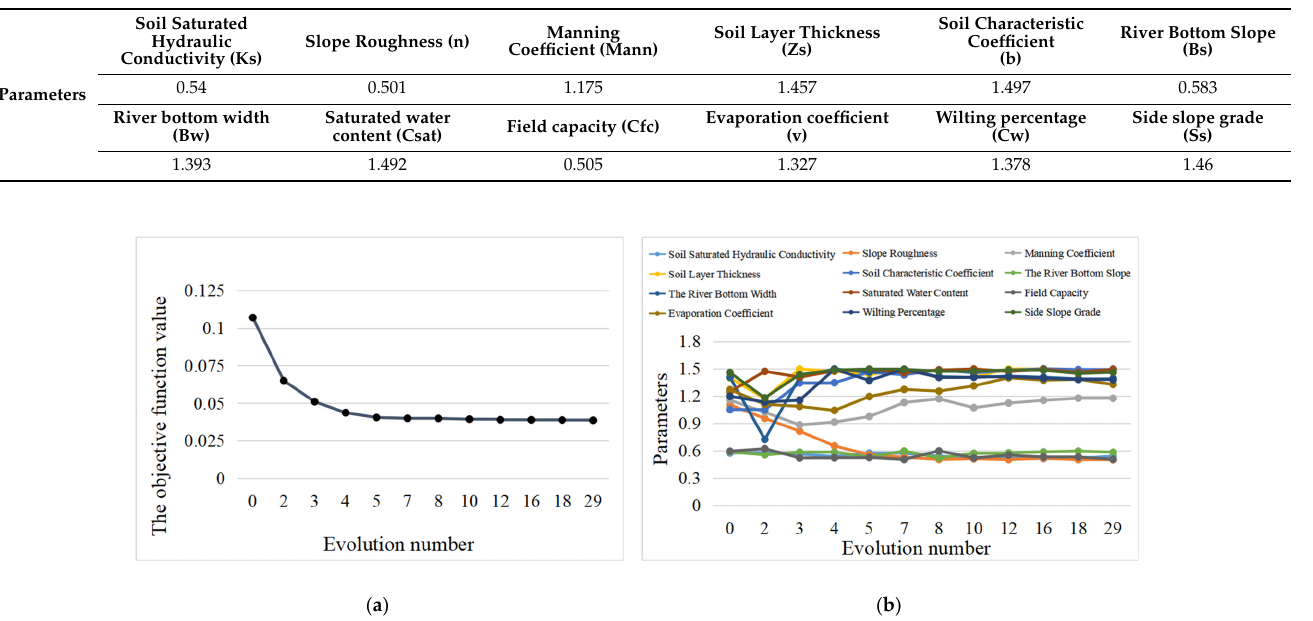
Figure 7. Results of the parameter optimization of the Liuxihe model with the particle swarm optimization (PSO) algorithm. ( a ) Change curve of the objective function; ( b ) parameter evolution process.